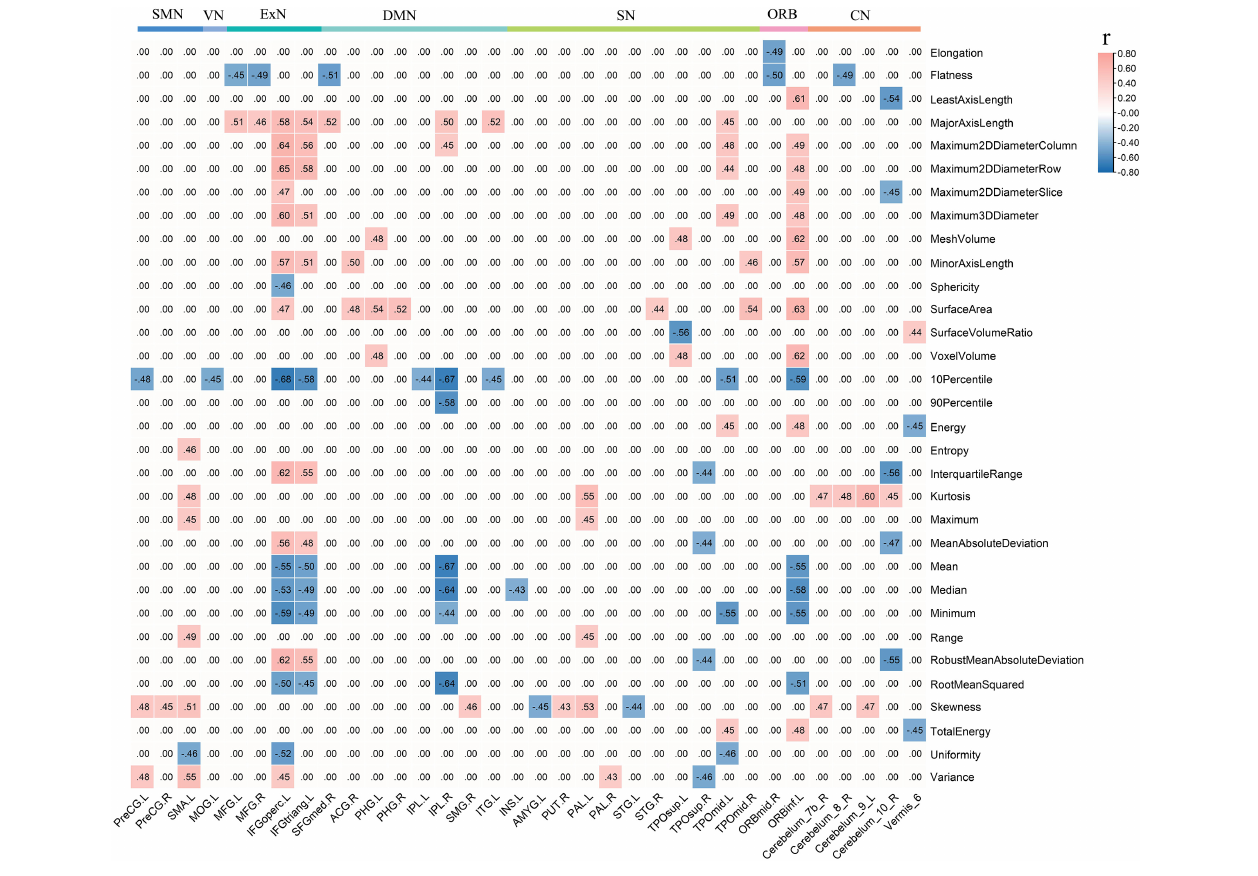
FIGURE 5 | Decreased local connections linked to CAU_L were correlated with radiomic features in iPSCI. CAU_L, left caudate; iPSCI, infarct post-stroke cognitive impairment; SMN, sensorimotor network; VN, visual network; ExN, external frontoparietal network; DMN, default-mode network; SN, salience network; ORB, orbitofrontal cortex; CN, cerebellum